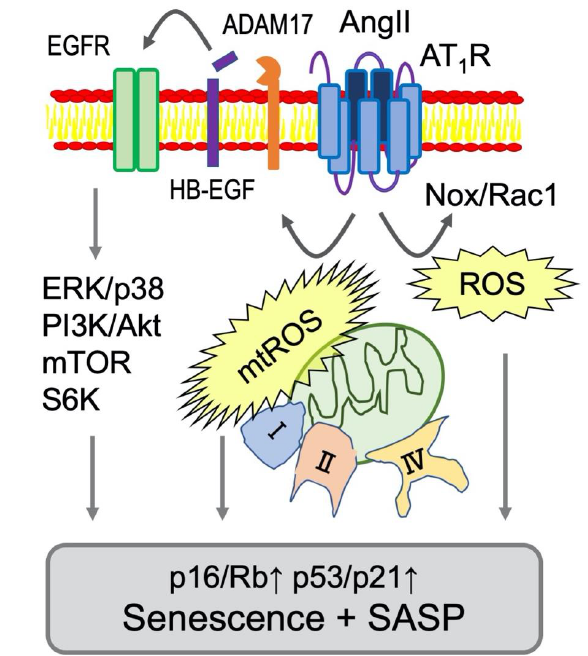
Figure 2. Signaling mediators of AngII-dependent senescence in VSMCs. Nox-derived ROS production is activated by AngII through AT 1 R and a small GTPase Rac1 [66,67]. In VSMCs,